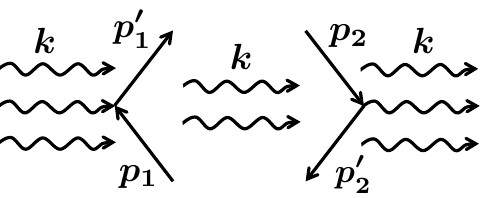
Figure 2: The pairing mechanism under consideration: the first electron absorbs a phonon from the wave, thus the second electron interacts with a modified wave and emits the same phonon. This virtual energy-conserving process can occur at times (cid:28) τ el − ph